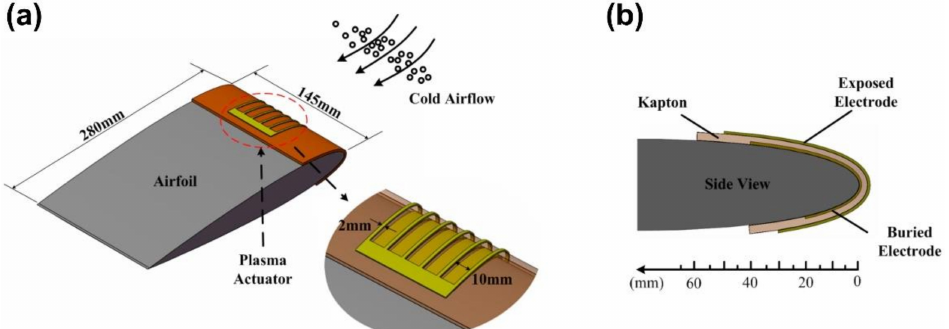
Figure 16. ( a ) Schematic of NACA 0012 airfoil with NS-DBD plasma actuator attached. ( b ) Side view of the airfoil with the NS-DBD (adapted from Chen et al. [177] under the Creative Commons Attribution